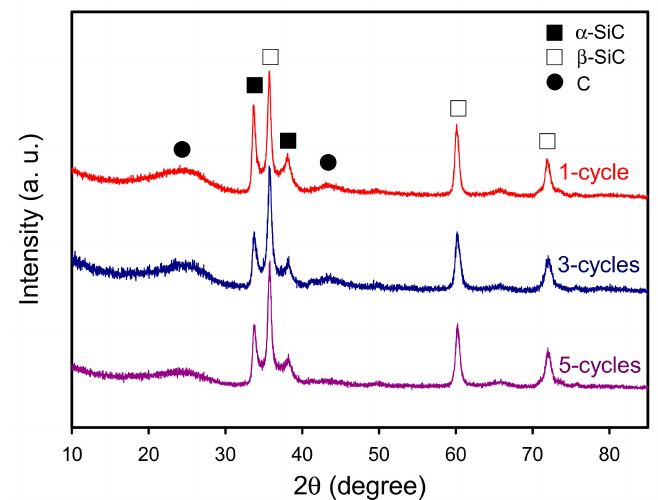
Figure 6. XRD patterns of sintered BcSiCs prepared using di ff erent repeated cycles of sol–gel impregnation